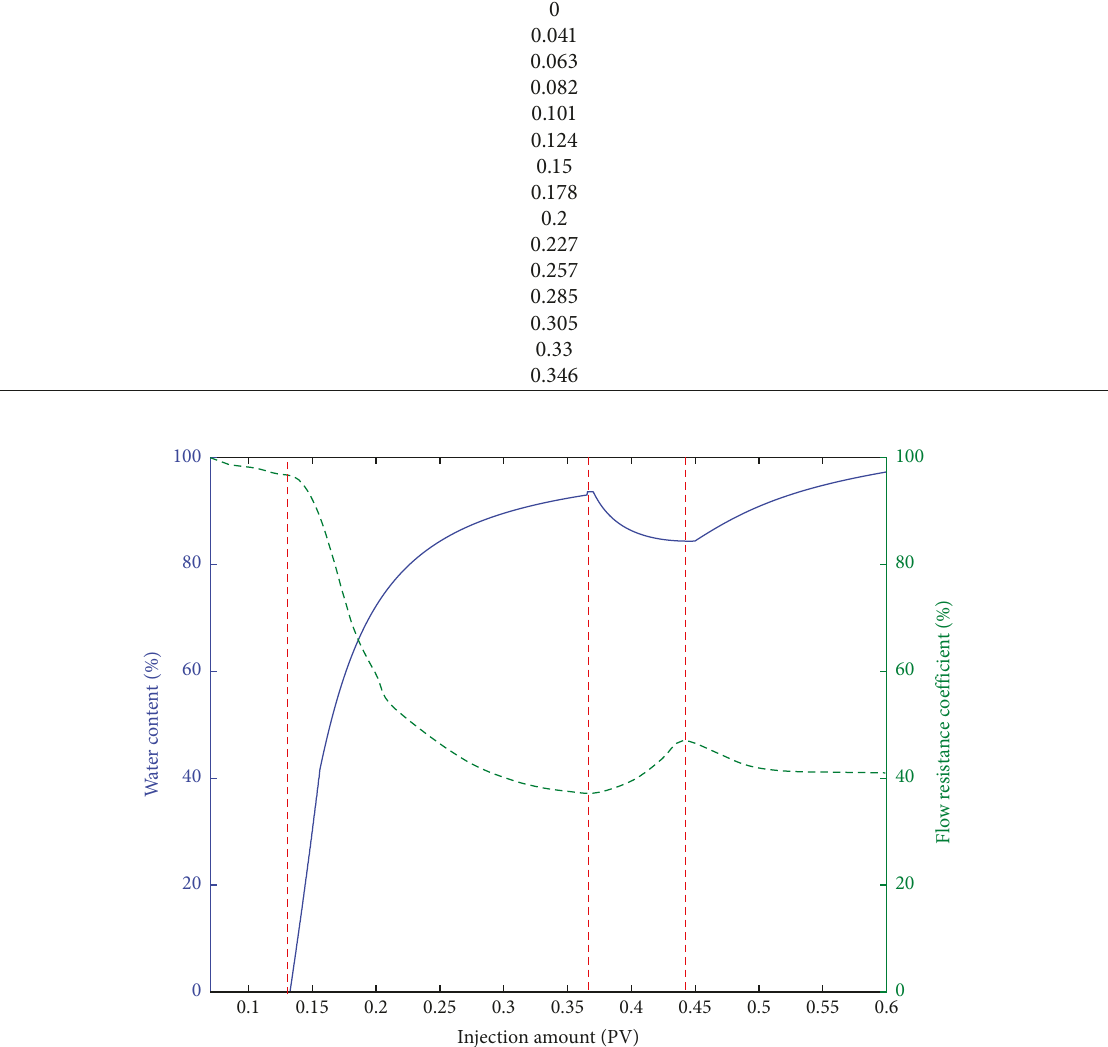
Figure 6: Curves of water content and flow resistance with time during polymer